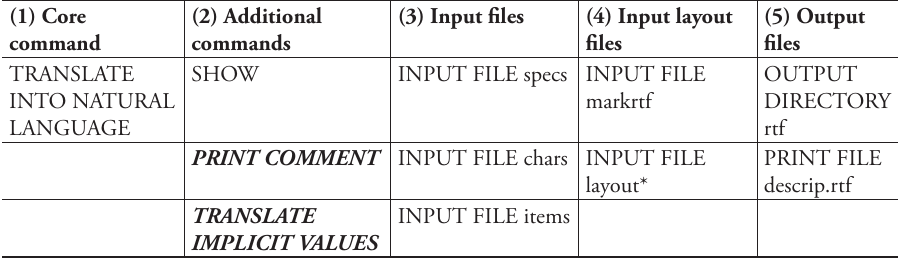
Table 4. Classifi cation of commands used in the tonatr directive fi le. Reference numbers used in Fig. 31 are given in the header of the table. Th e commands in bold and italics may require changes being made by the user.